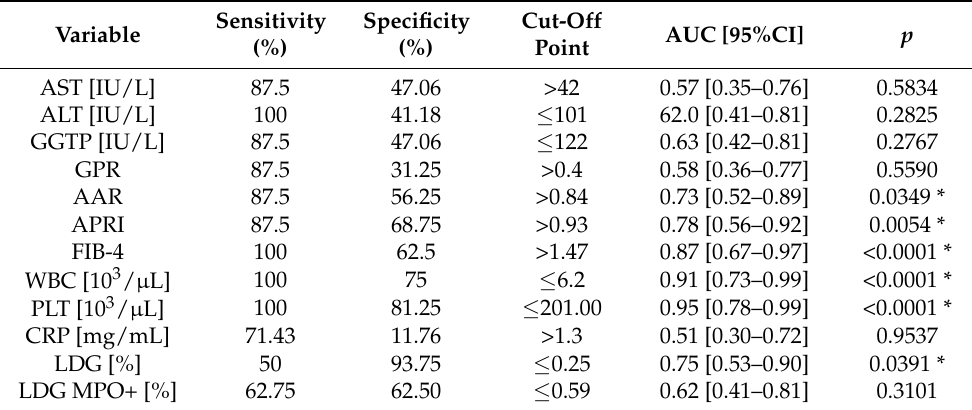
Table 3. Assessment of the diagnostic usefulness of selected biochemical and inflammatory markers, including the percentage of LDG and the LDG fraction showing MPO expression in the detection of LC in the course of AIH.